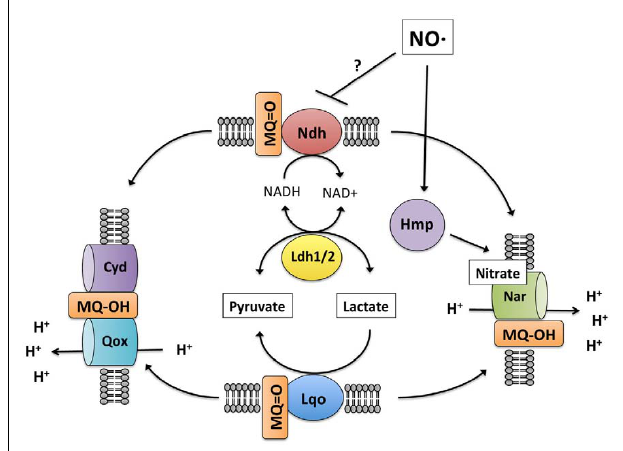
FIGURE 6 | Model of S. aureus lactate metabolism. During respiratory lactate catabolism (either aerobically or anaerobically on nitrate), S. aureus can use either Lqo or reversal of the NADH-dependent Ldh1/2 provided NADH can be recycled. In the absence of an external electron acceptor, S. aureus is unable to catabolize lactate because Lqo activity requires a functioning quinol oxidase as does Ldh1/2 for NAD + regeneration. Initially during NO · stress, respiration is inhibited and lactate is produced for redox balance (NAD + generation). Once respiration resumes due to waning NO · levels, lactate can be assimilated but only in an Lqo-dependent fashion. Despite the presence of active quinol oxidases (Qox, Cyd, or Nar) NADH-dependent Ldh1/2 do not promote lactate assimilation in the presence of NO · .This would be consistent with NO · -dependent inhibition of Ndh, limiting NAD + regeneration even in the presence of active quinol oxidases, though this remains to be